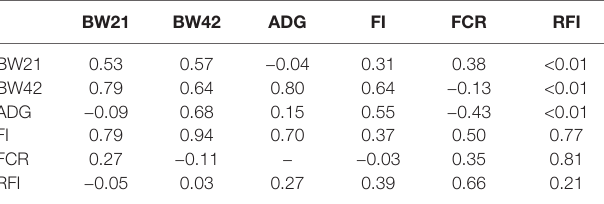
TABLE 2 | Genomic heritability and genetic correlation of feeding traits.